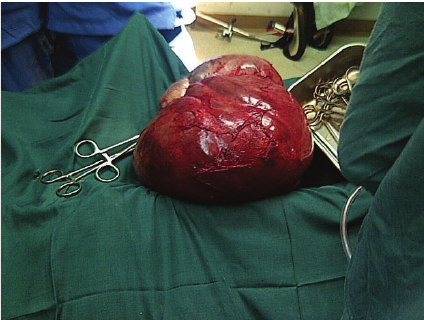
Figure 2: The ovarian tumour excised.